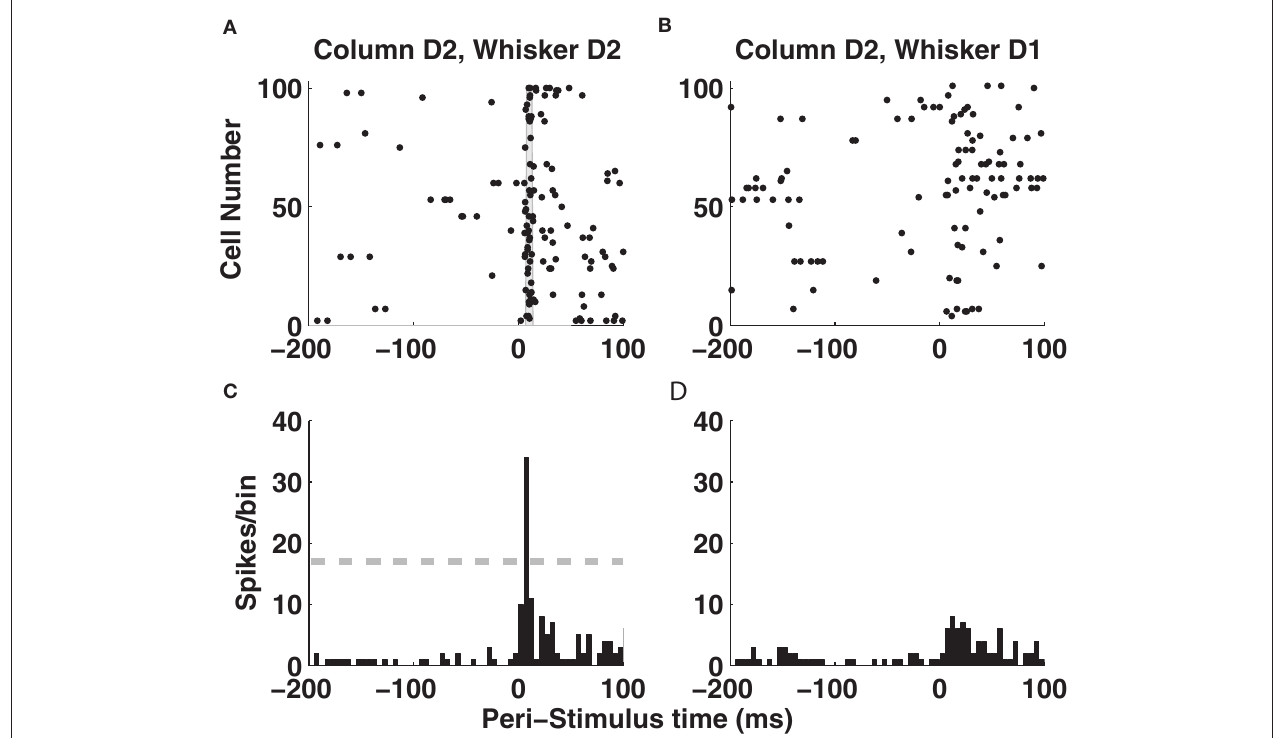
time of deflection of the whisker D1. (C) The time course (sampled in 5-ms bins) of the summed activity of the whole population of D2 neurons around the time of deflection of D2 whisker in the same trial plotted in (A) . The dashed horizontal line plots the threshold used to detect a “columnar synchronous response” (CSR) event. ( D) The time course of the summed activity of the whole population of D2 neurons around the time of deflection of D1 whisker in the same trial plotted in (B)